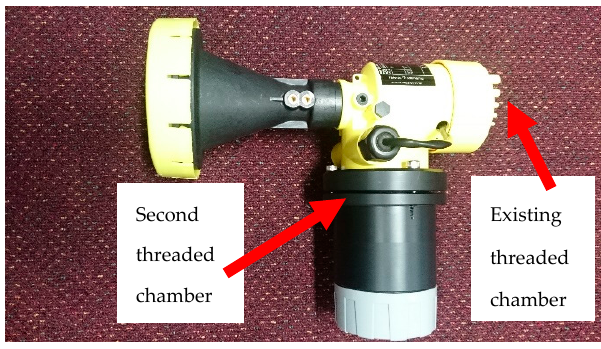
Figure 6. Portable radar chambers.